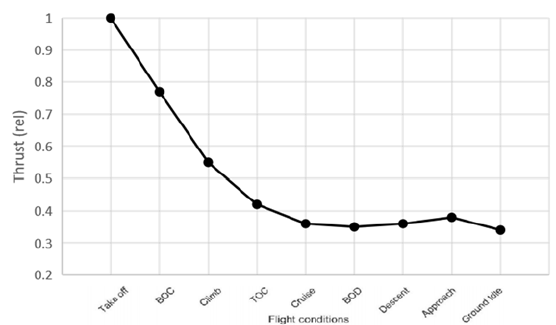
Figure 17. Thrust requirement for different flight conditions. BOC: beginning of climb; TOC: top of climb; and BOD: beginning of descent.